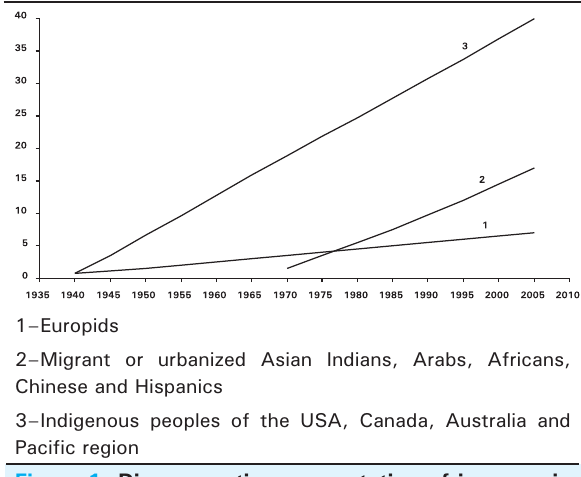
Figure 1. Diagrammatic representation of increase in diabetes prevalence in different populations of the world RAPID AND ACCELERATED RISES OF